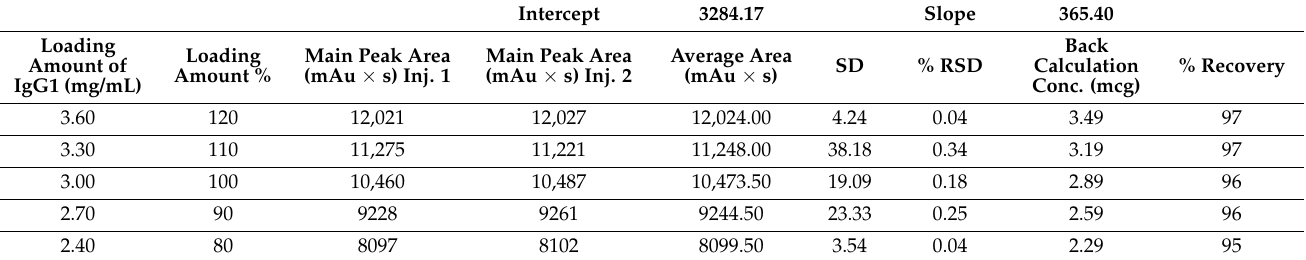
Figure 3. Slope and intercept calculation using loading amount versus main peak area obtained form 80–120% of loading amount. Table 2. Compiled linearity set data in duplicate injection with loading amount of IgG1 sample from 80 to 120%. Slope and intercept are taken from Figure 3. Intercept 3284.17 Slope